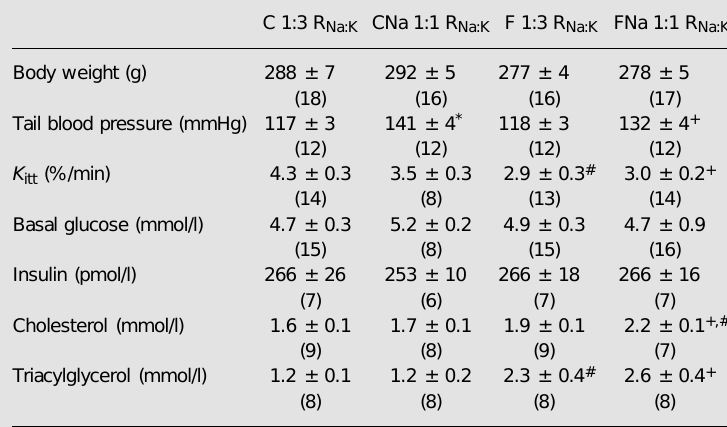
Table 1. Body weight, blood pressure, and serum glucose, insulin, triacylglycerol and cholesterol levels in rats randomly divided into four diet groups: control, 1:3 sodium/ potassium ratio diet (C 1:3 R Na:K ); control, 1:1 sodium/potassium ratio diet (CNa 1:1 R Na:K ); high-fructose, 1:3 sodium/potassium ratio diet (F 1:3 R Na:K ), and high-fructose, 1:1 sodium/potassium ratio diet (FNa 1:1 R Na:K ) for the next 28